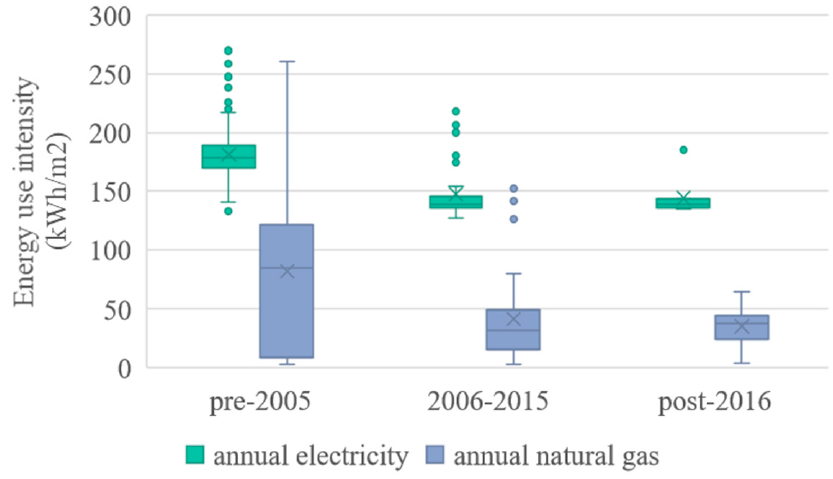
Table 8. The input parameters used in office space.